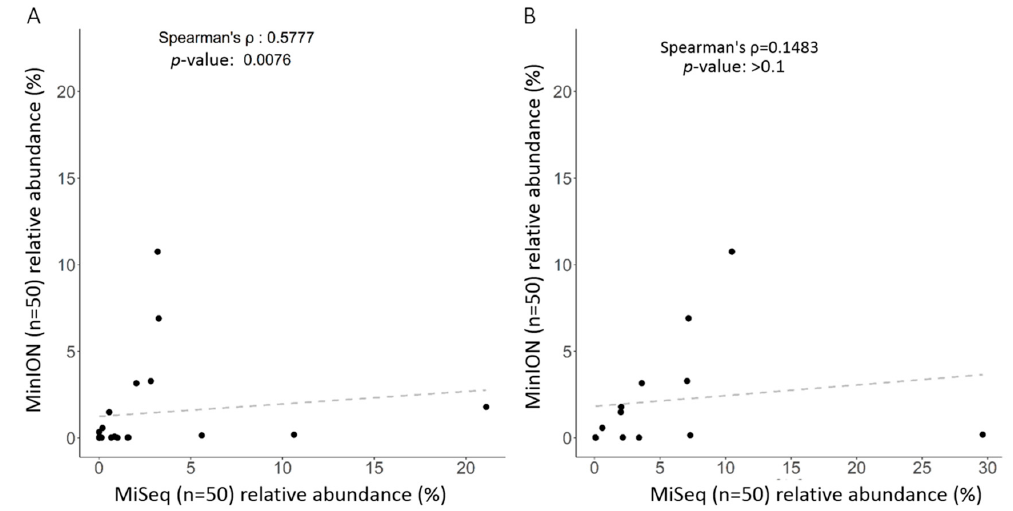
Figure 6. Correlation of identified taxa using short-read sequencing coupled with SILVA reference or long-read sequencing coupled with EPI2ME algorithm with NCBI database: ( A ) at the genus level; or ( B ) at the species level.